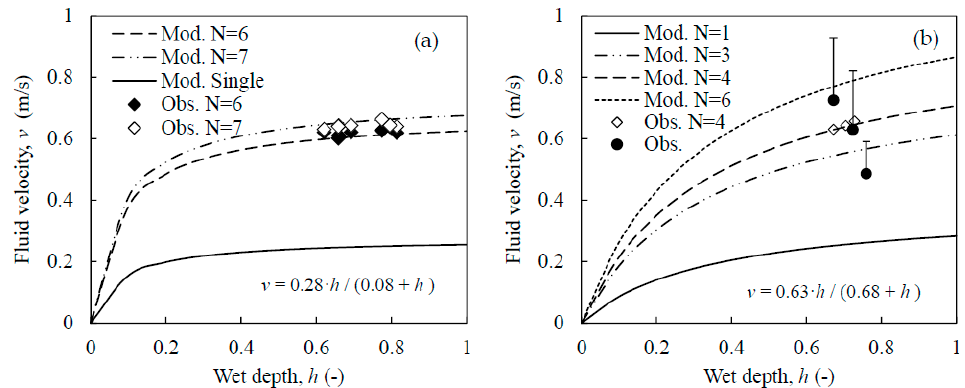
Figure 4. The observation and modeling of fluid velocities. ( a ) Φ 1400 mm disks in the ML and IL (the running numbers N are 7 and 6 in the ML and IL, respectively); ( b ) Φ 1800 mm disks in the OL— N varies from 3 to 6, and the error bar represents the standard deviation ( n = 6). Rotating frequency ω is 60 rpm. Dots are observation data, lines are modeling results. Mod and Obs refer to modeling and observation, respectively. IL, ML, and OL are abbreviations of the inner, middle and outer lane, respectively.